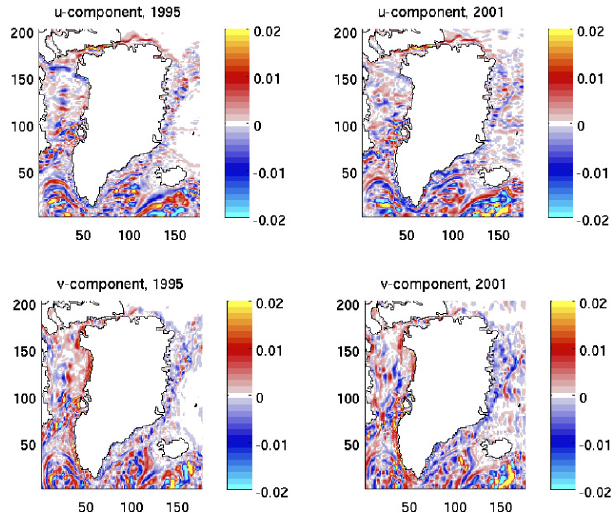
Fig. 16. Differences (sensitivity minus control) in the zonal and meridional component (upper and lower panels respectively) of depth-averaged currents (ms − 1 ) , in 1995 and 2001 (left and right panels respectively). Anomalies of the zonal component are posi- tive eastwards. Anomalies of the meridional component are positive